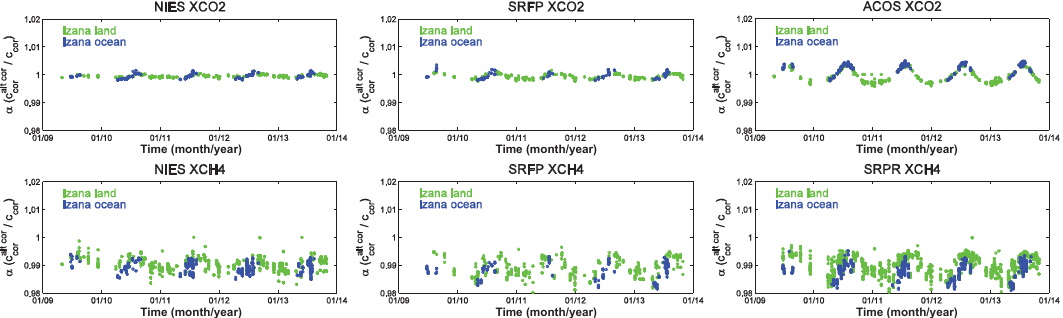
Figure 3. The time series plots of XCO 2 and XCH 4 altitude-correction factors for different GOSAT algorithms at the Izaña site. Blue data points are sun glint data over ocean and the green ones are data above